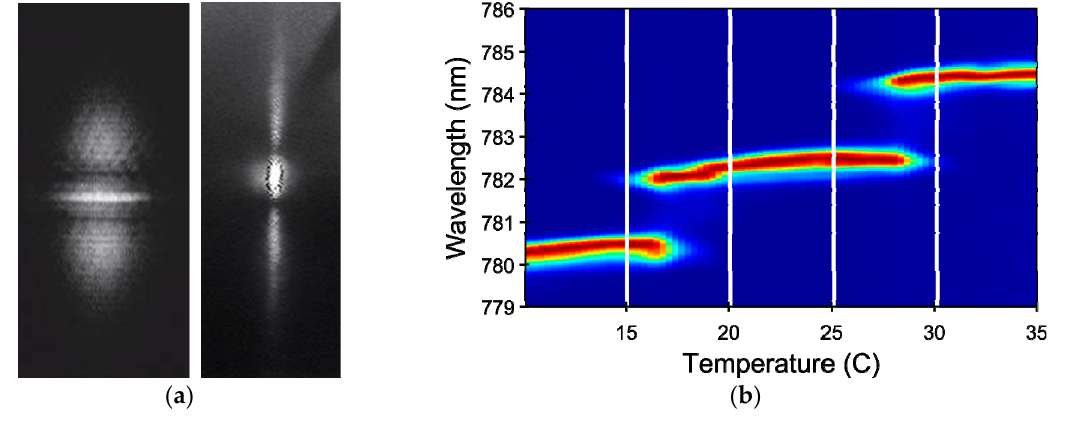
Figure 3. ( a ) Measured near- and far-field emissions of a laser emitting on the Bragg mode; ( b ) Normalized laser emission intensity as a function of wavelength and heat-sink temperature.